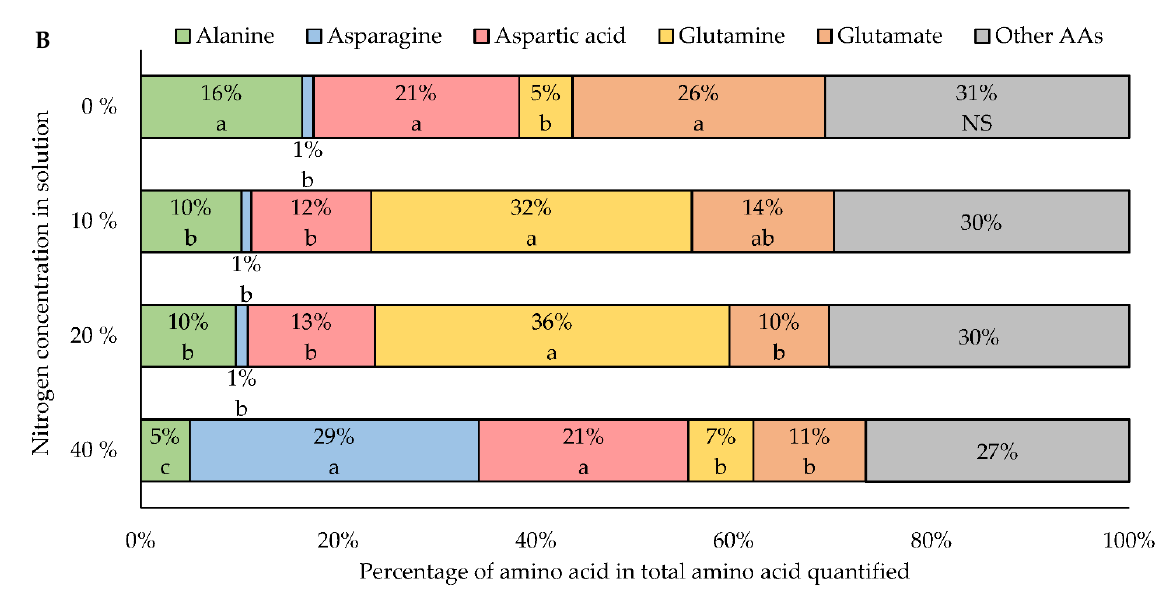
Figure 7. Absolute ( A ) and relative ( B ) concentrations of free amino acids in the youngest and second youngest fully expanded leaves of spring wheat (cv. Amaretto) foliar fertilized with UAN in different N concentrations (0, 10, and 20% of N) at 6 HAFNf. Data are the means of three independent biological replicates ± standard error; letters indicate a difference between the N treatments according to Tukey’s post hoc test ( p < 0.05). “Other AAs” are the sum of the percentage of arginine, serine, threonine, valine, isoleucine, leucine, and phenylalanine. Pearson correlation was performed at 6 HAFNf, when total-N, NH 4+ , and amino acids concentration, as well as GS activity, were evaluated in the youngest and second youngest fully expanded leaves. The leaf NH 4+ concentration was positively correlated with Asn (R 2 = 0.95) and total-N (R 2 = 0.95) but correlated negatively with the GS activity (R 2 = −0.86) (Figure 8). GS activity was negatively correlated with Asn (R 2 = −0.84) and total-N (R 2 = −0.87) .